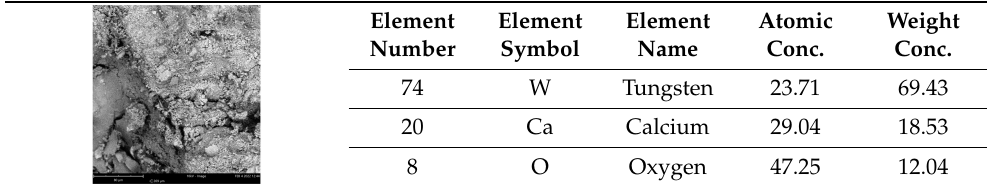
Table 16. SEM-EDS result for Y 4 concrete sample spot